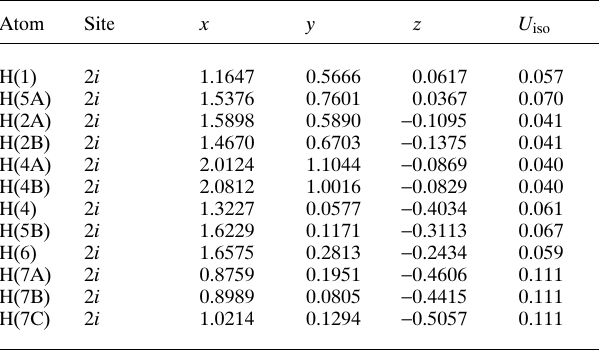
Table 2. Atomic coordinates and displacement parameters (in Å 2 ) .